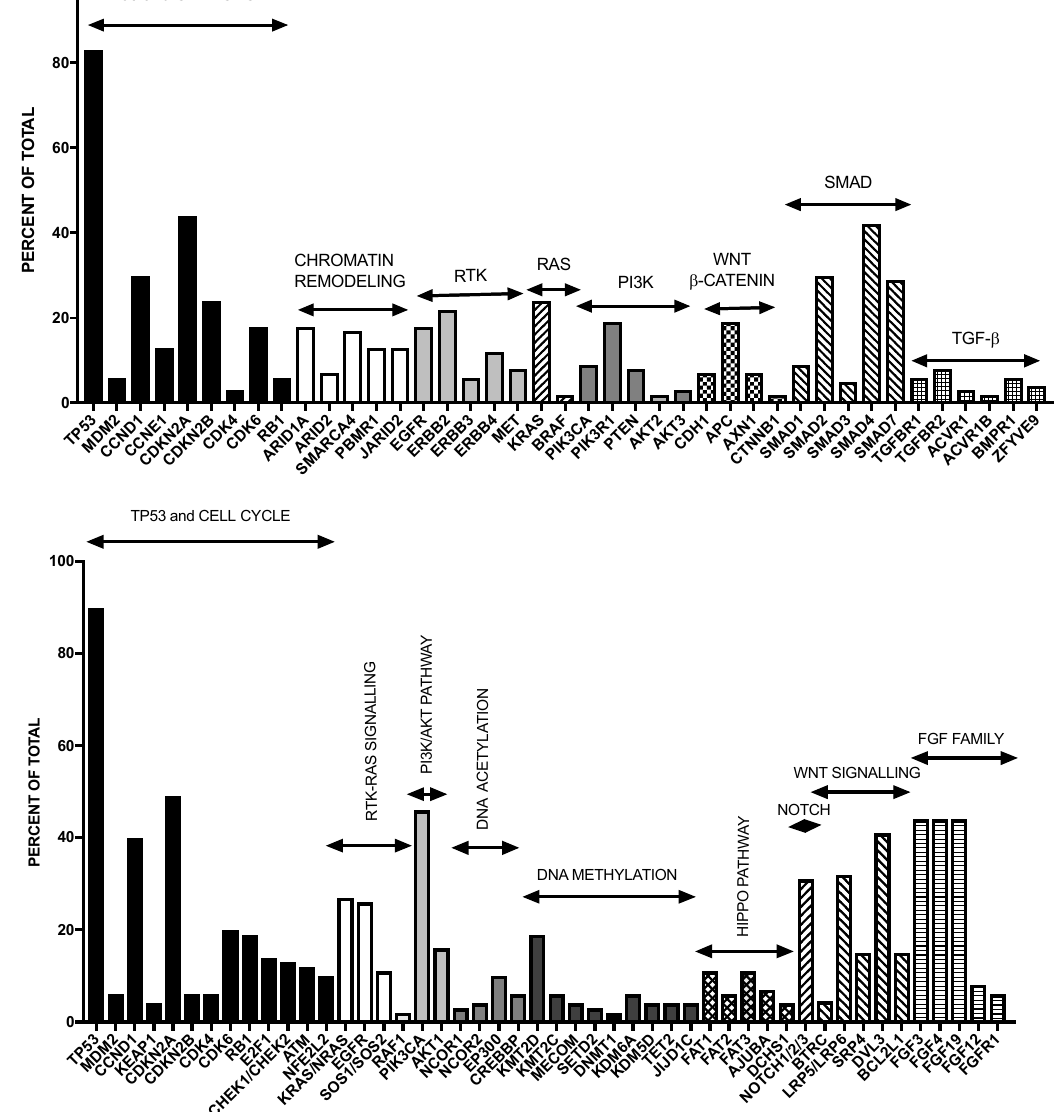
Figure 1. Frequency of the main genetic alterations observed in esophageal adenocarcinoma (EAC) ( top panel ) and in esophageal squamous carcinoma (ESCC) ( bottom panel ). The figure reports the cumulated frequency of both mutations and copy number alterations for the various genes indicated.